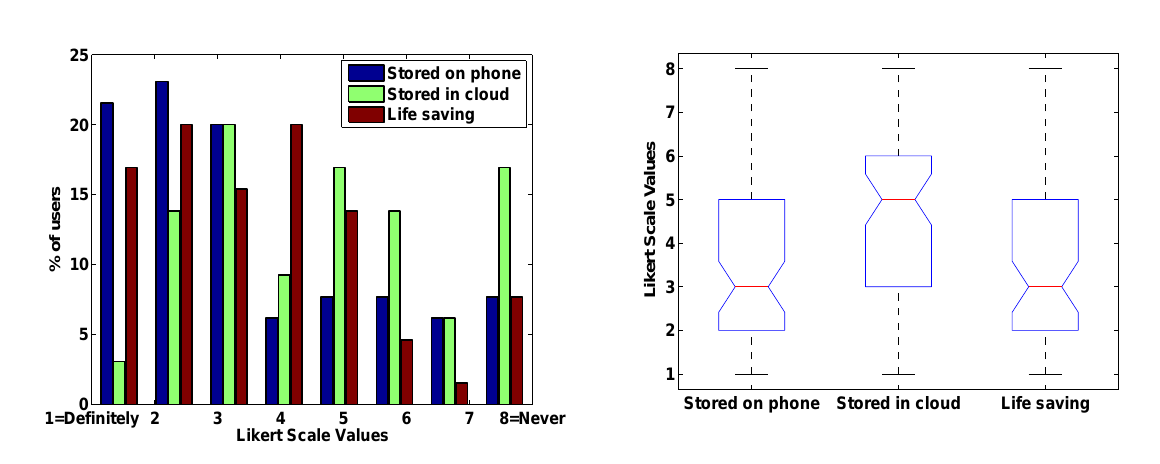
Figure 3. Responses to Sensitive Data Collection Question (best viewed in color)